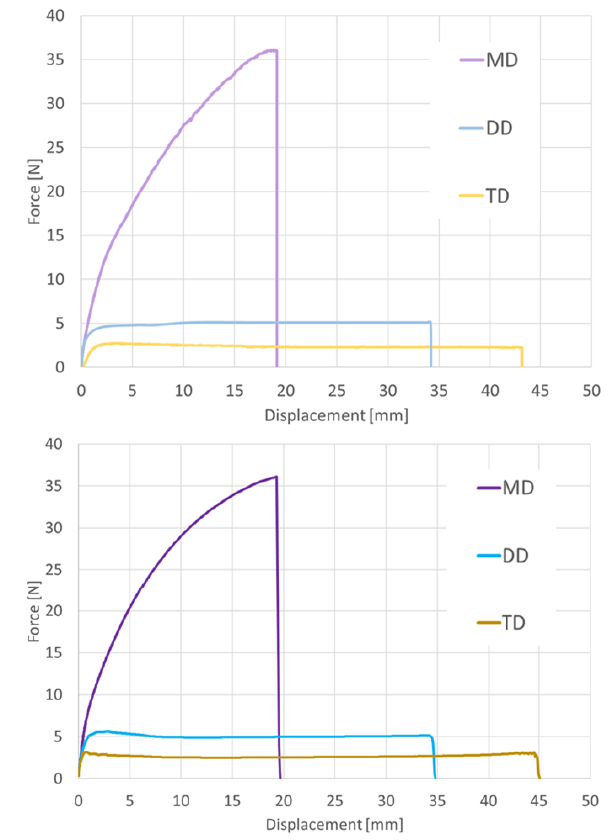
Figure 14. Force vs. displacement curves: real test ( upper ) vs. simulation ( lower ) for the three oriented specimens (MD, DD and TD).